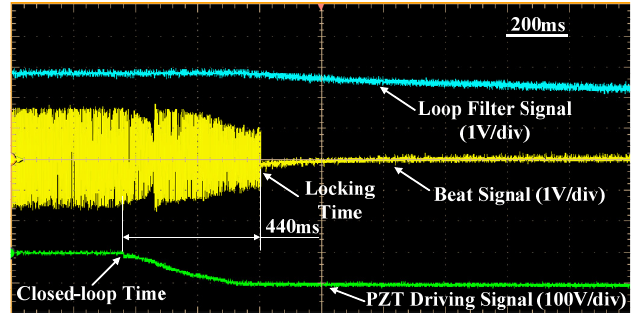
Figure 5. Frequency acquisition and phase locking process at a 164 MHz initial frequency difference.